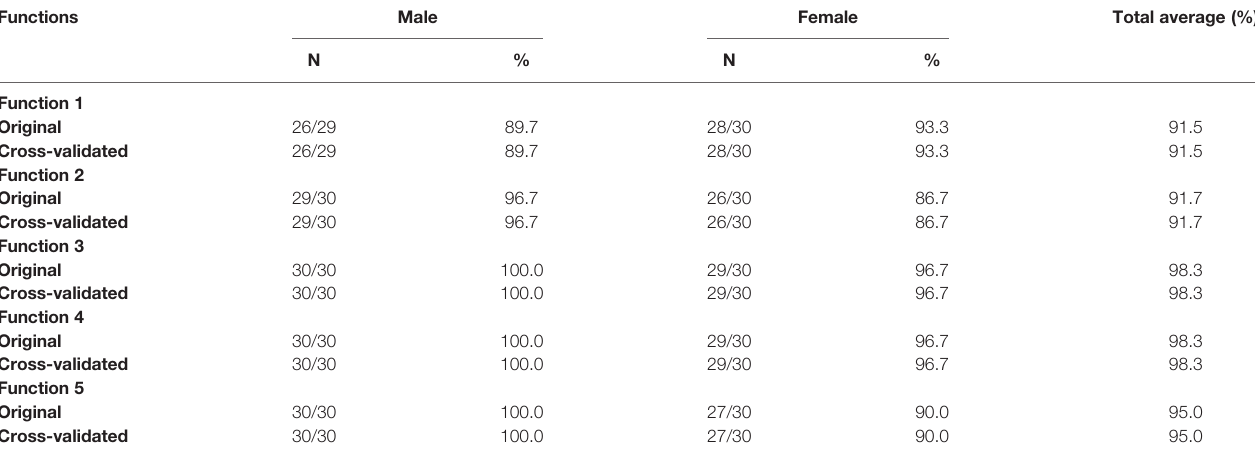
TABLE 9B | Accuracy of classi fi cation results of the original and cross-validated samples (right side).